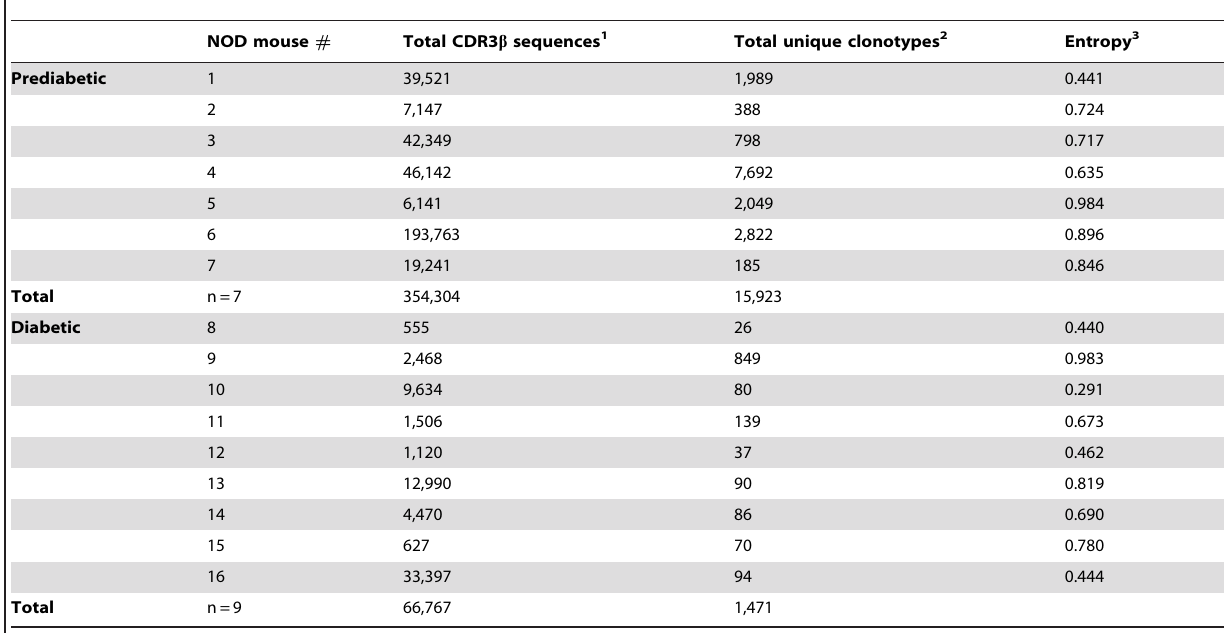
Table 1. CDR3 b sequences of islet-infiltrating CD4 + CD44 high T cells.